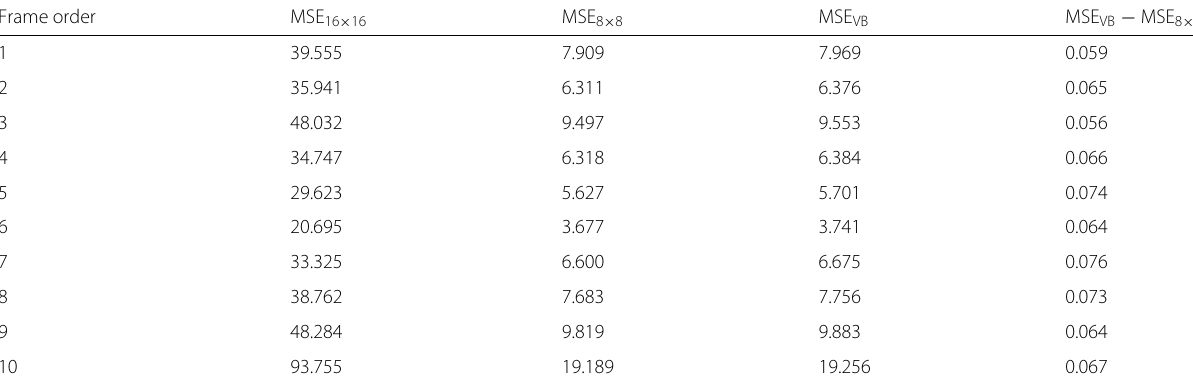
Table 5 Comparison of MSEs between variable- and fixed-size blocks (16 × 16, 16 × 8, 8 × 16, and 8 × 8) Frame order